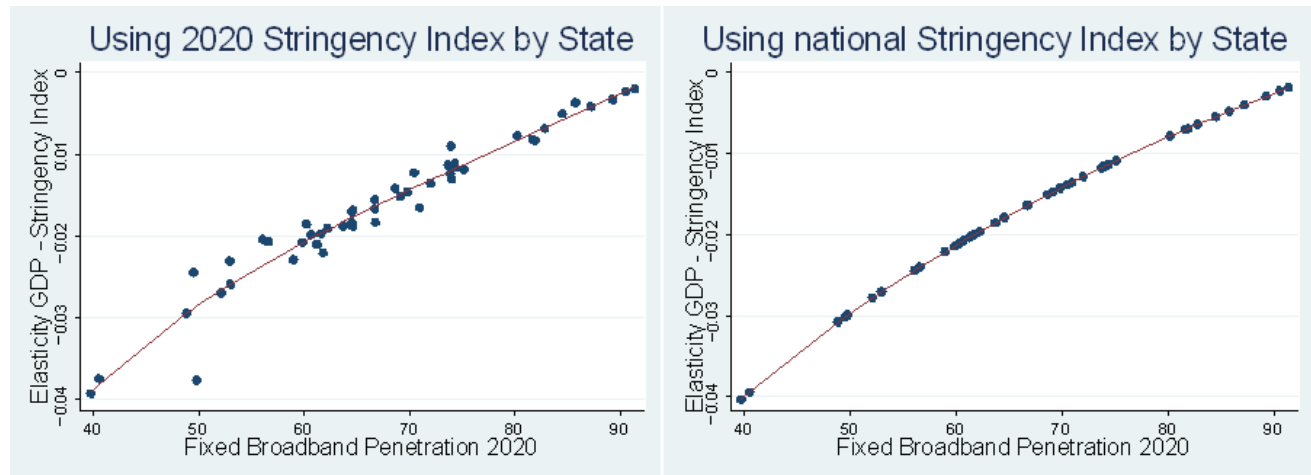
Figure 5. Elasticity GDP — Stringency Index by level of BB penetration.